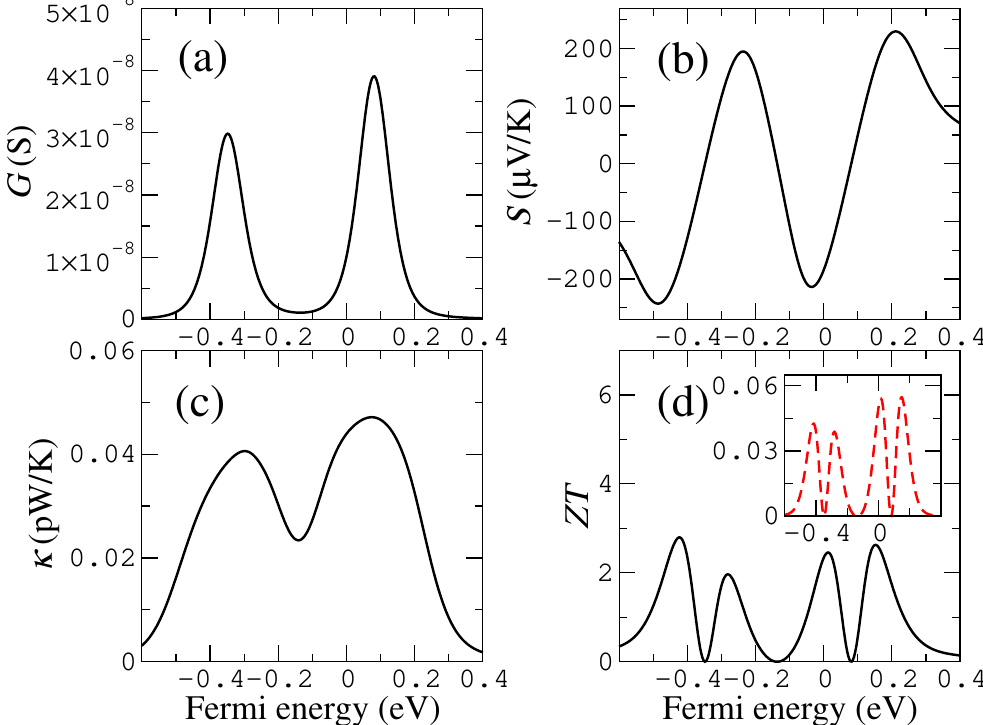
Figure A2. Electrical conductance ( a ), Seebeck coefficient ( b ), thermal conductance ( c ) and figure of merit ( d ) for a graphene wedge facing a straight edge. The inset shows the figure of merit calculated with a phonon thermal conductance of 2